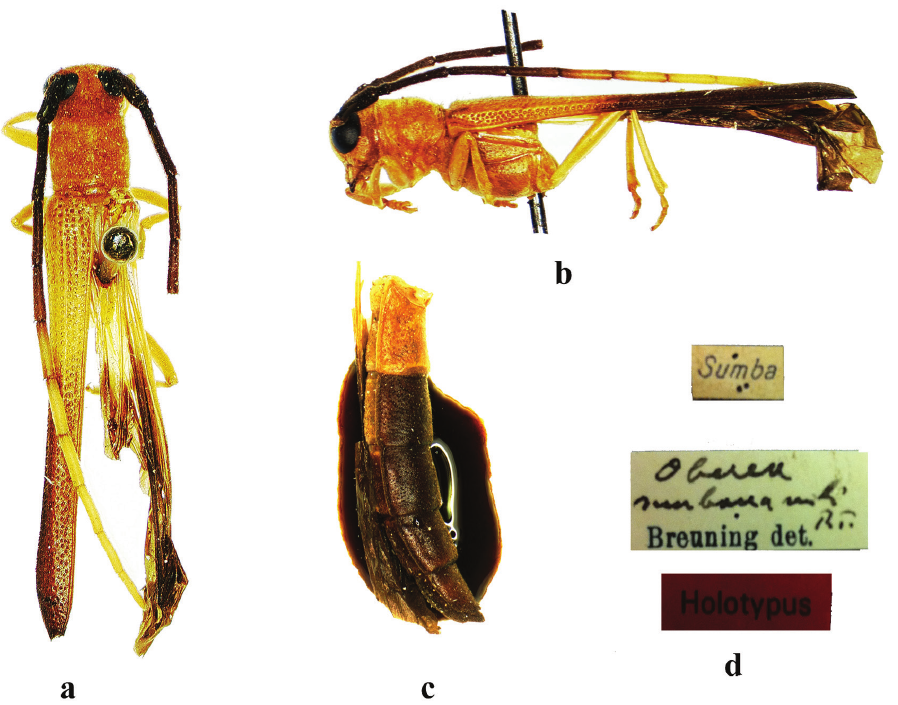
Figure 10. Habitus of O. sumbana Breuning, 1961, holotype, male, from Sumba, a dorsal view b lateral view (without abdomen) c abdomen, lateral view d label. (not to